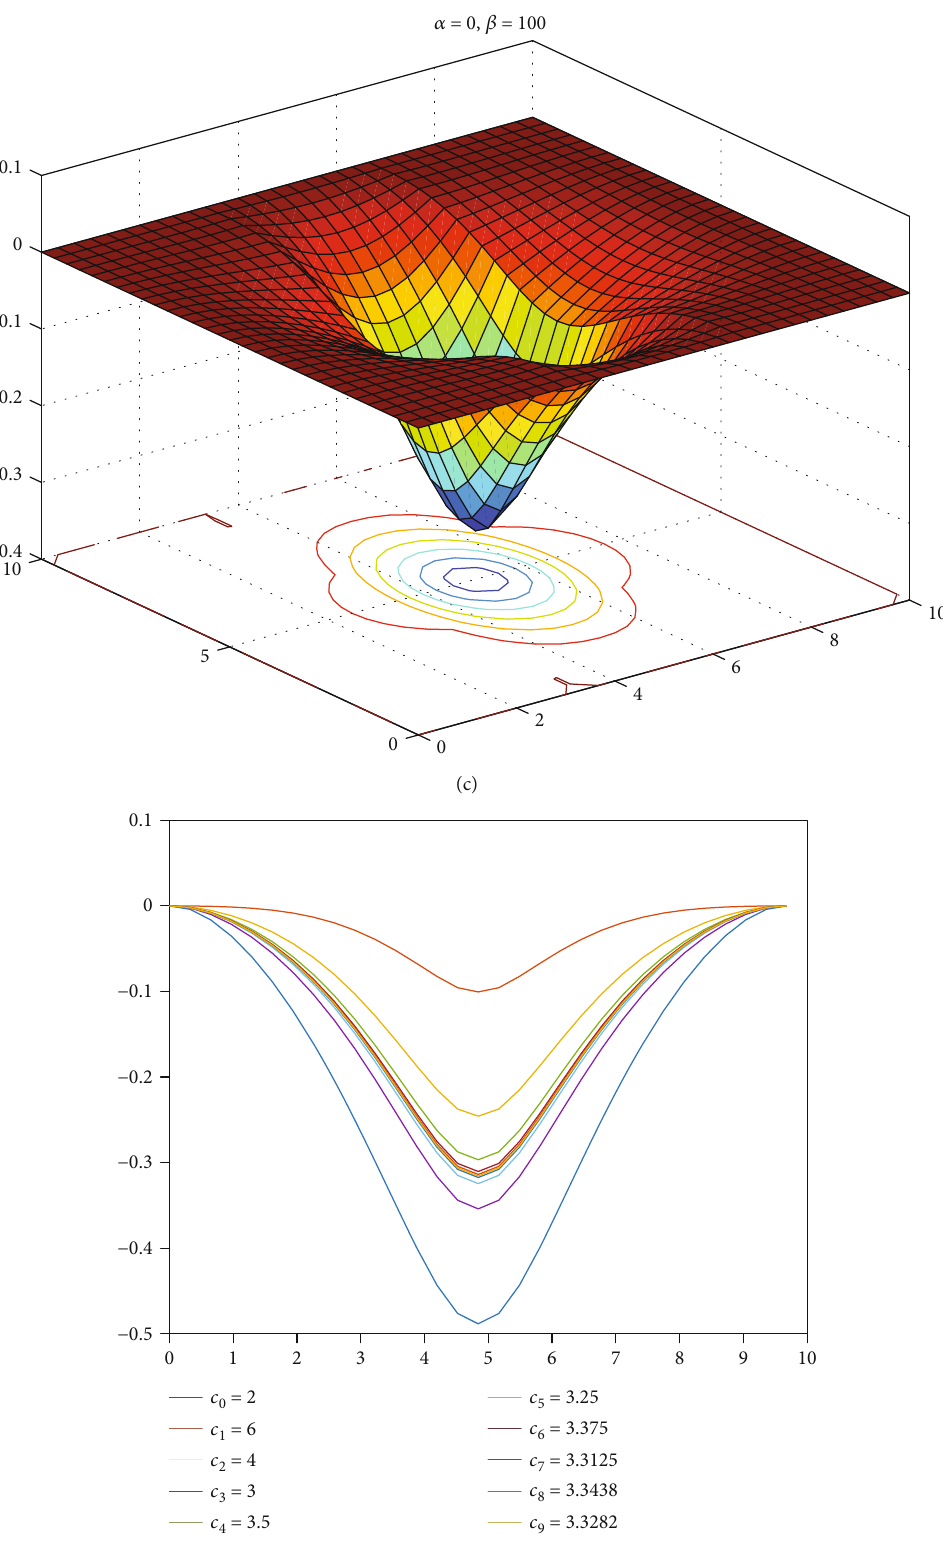
= 2 , (b) c = 6 , (c) c = 3 : 3282 , and (d) bending of the system for Case 2 in the case of α = 0, β = 100 Figure 4: (a) c 0 1 9